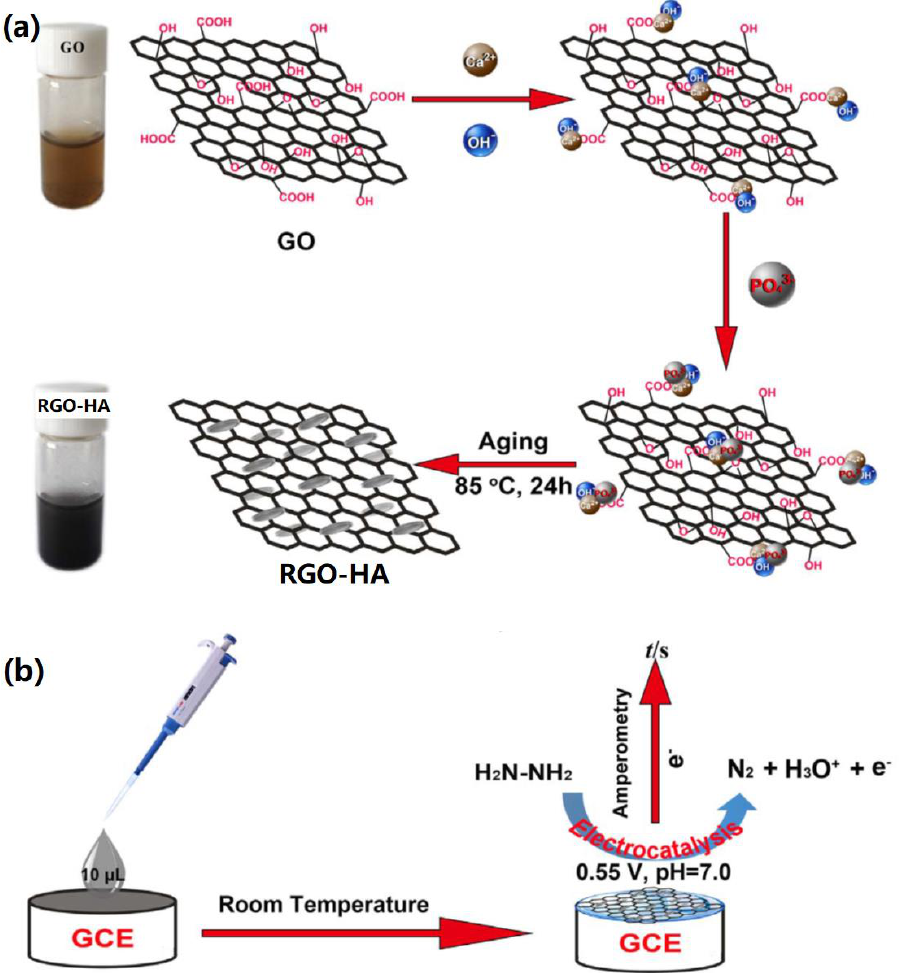
Figure 9. Biomimetic RGO-HA for biosensor application: ( a ) Synthesis mechanism of RGO-HA nanohybrids, ( b ) Sensing mechanism of hydrazine. Reproduced with the permission from ref. [90]. Copyright 2017 Elsevier Ltd.